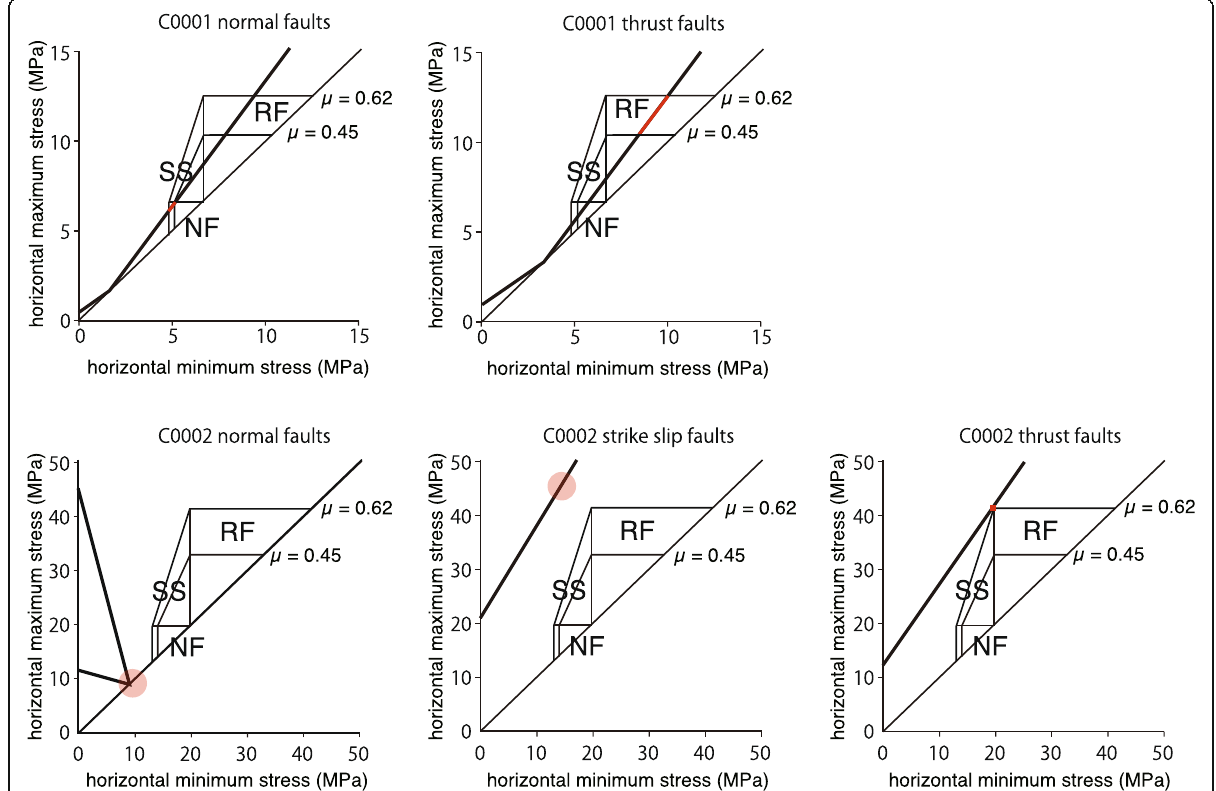
Fig. 6 Constraints on stress magnitude in the horizontal maximum and minimum principal stress spaces for each type of fault and each site. The two stress polygons correspond to internal frictions of 0.45 and 0.62 (smaller and larger areas, respectively). Thick black lines show linear relationships derived from paleo-stress state. Red segments of the lines represent the constrained stress magnitudes. Pale red circles indicate the closest points on the thick lines to the stress polygons in two of the diagrams (C0002 normal fault and C0002 strike-slip